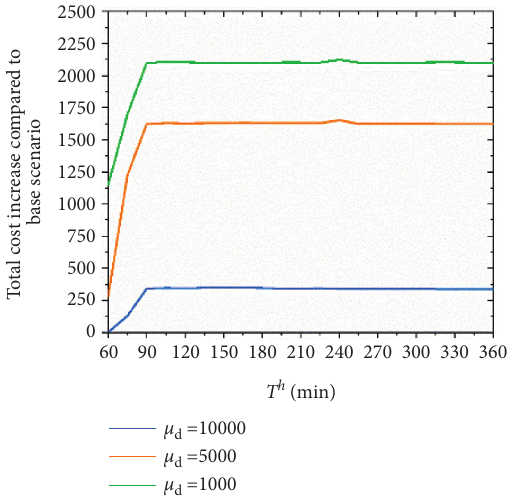
Figure 19: The total cost increases with different relocation dis- tance